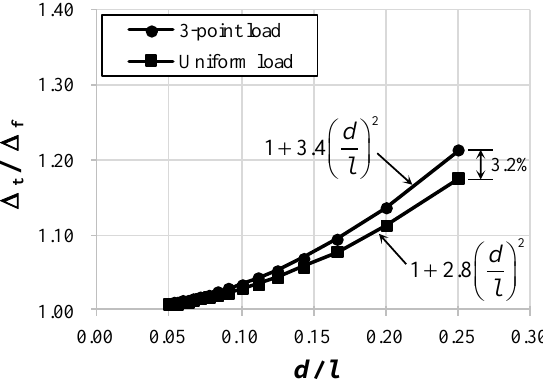
Figure 5. Calculation Results of Elastic Analysis using Equation (4).